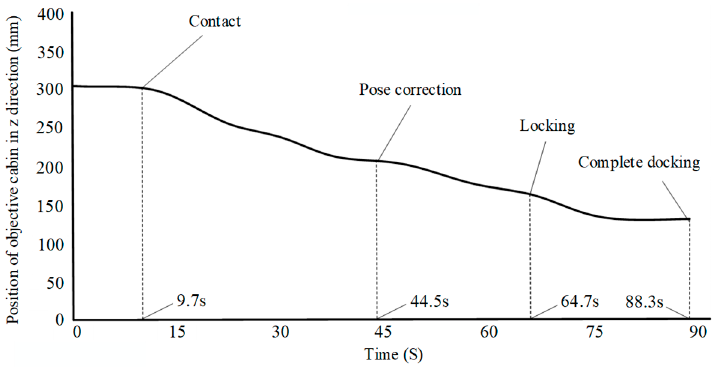
Figure 8. Position of the target satellite in docking direction.